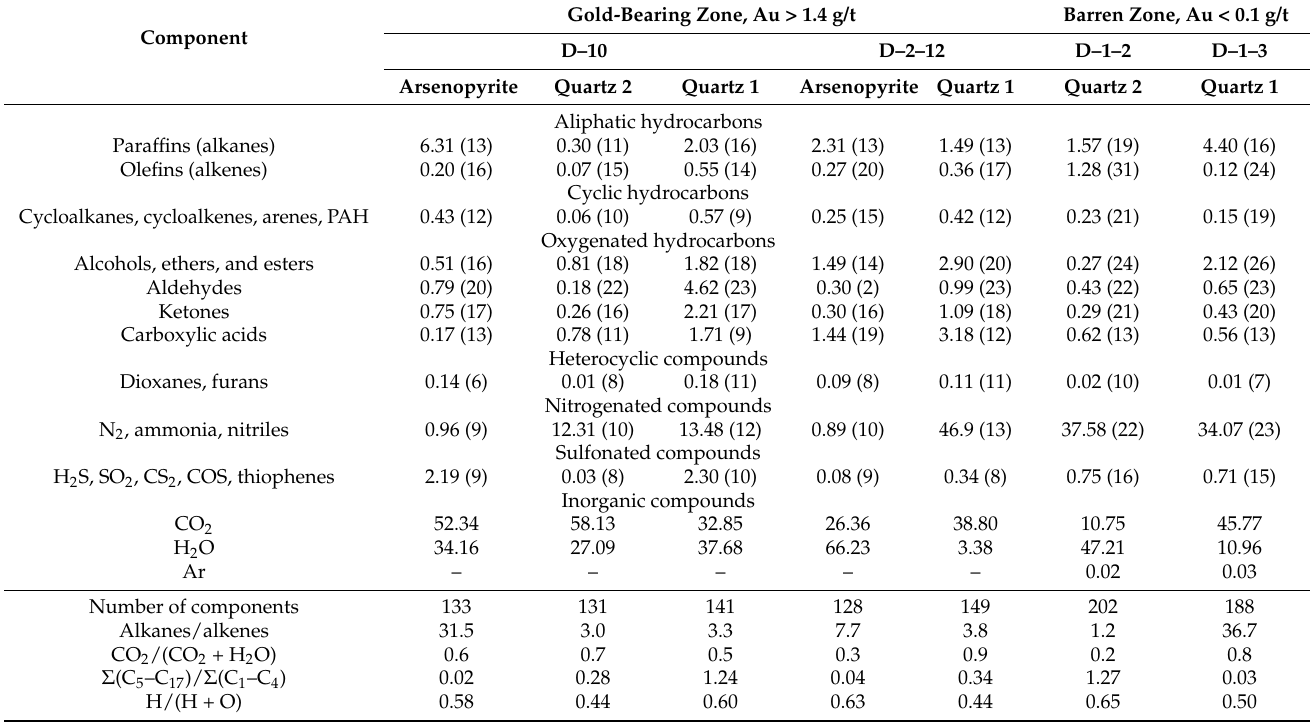
Table 3. Content (rel.%) and number (in parentheses) of volatiles extracted via mechanical shock destruction of minerals from the Dobroe deposit (according to a GC–MS).